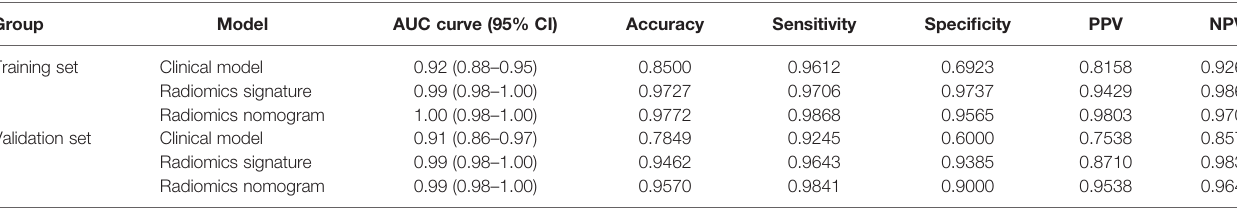
TABLE 2 | The clinical model, radiomics signature, and radiomics nomogram for patients with LAC and LTB in training and validation sets. Group